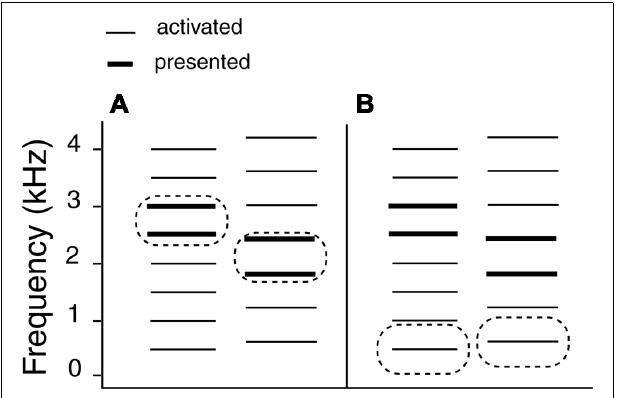
FIGURE 1 |Two modes of pitch perception. A pair of pure tones (2500 + 3000 Hz) is succeeded by another (1800 + 2400 Hz).The tone pairs activate harmonic templates of different fundamental frequencies (500 and 600 Hz, respectively). (A) Spectral mode. A descending melodic contour is derived from the frequencies of audible components. (B) Virtual mode. An ascending contour is derived from the missing fundamental frequencies based on the mutual distance of individual harmonic